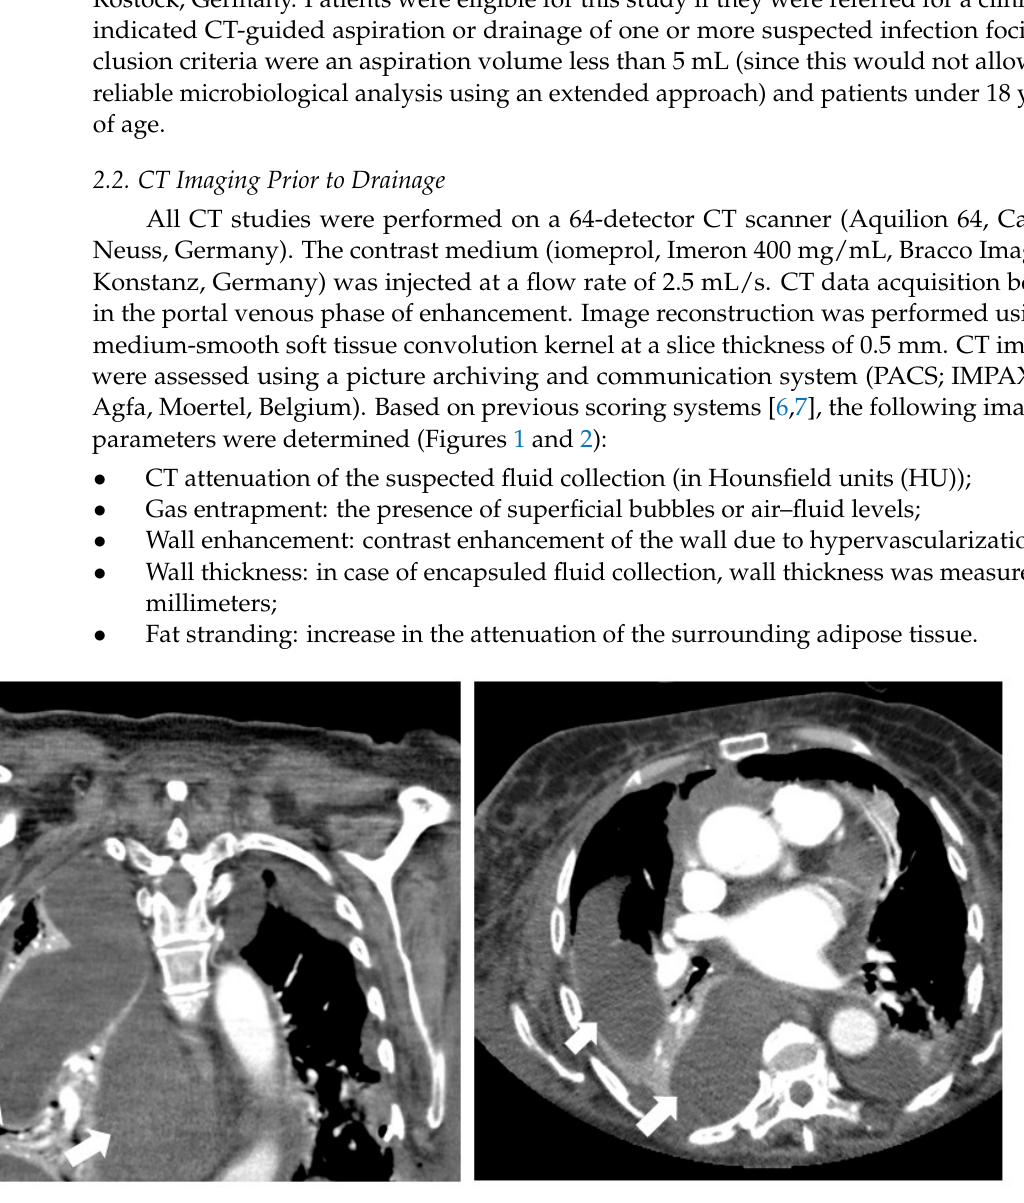
Figure 1. An 83-year-old woman with chambered pleural effusion ( → ) and CT attenuation of 8 HU. After percutaneous drainage, no pathogen was detected by microbiological approach.